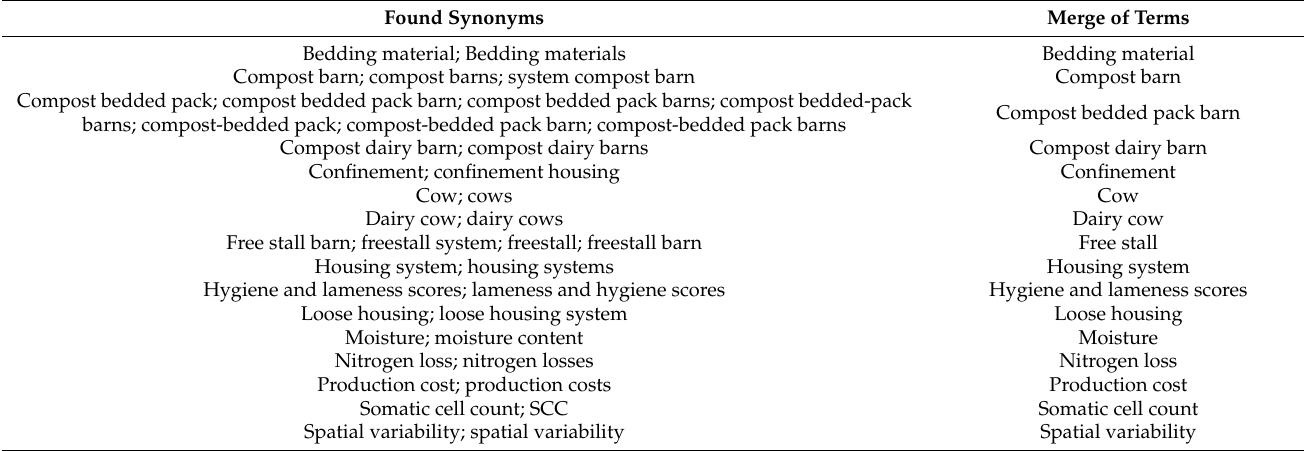
Table 4. Dictionary of synonyms based on keywords found in